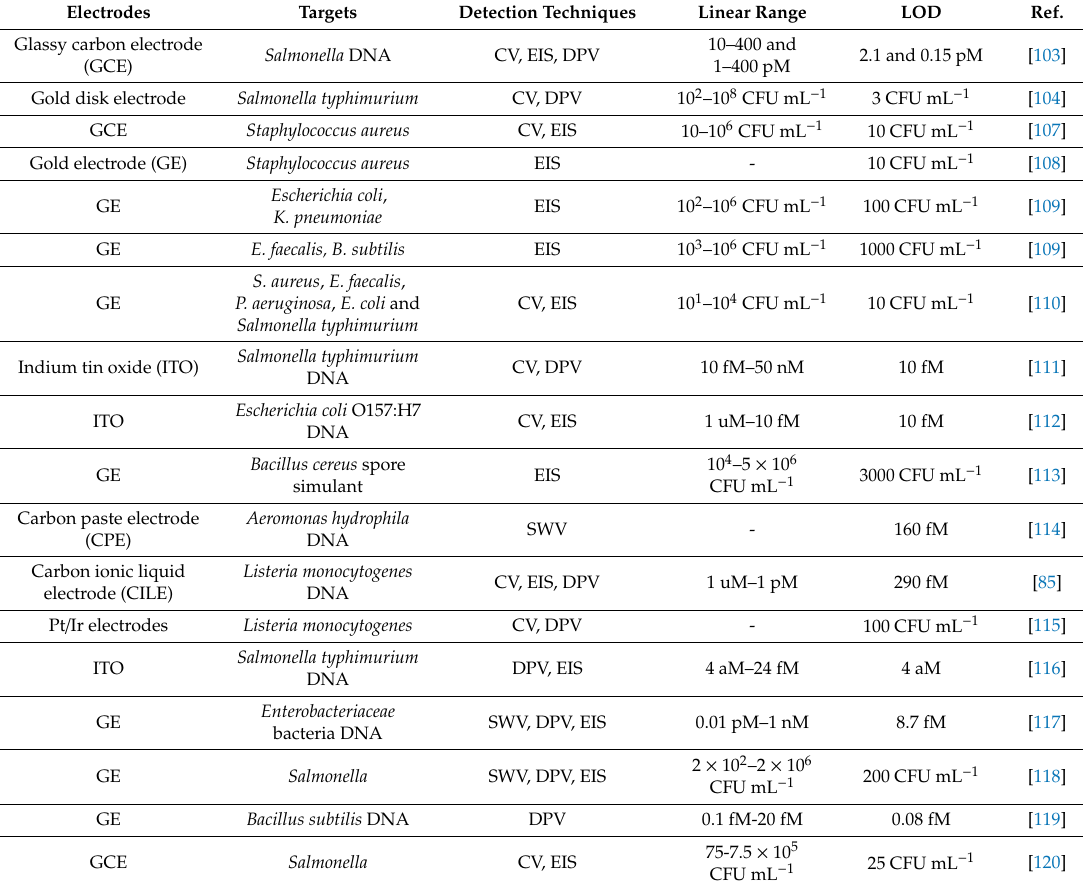
Table 4. Electrochemical